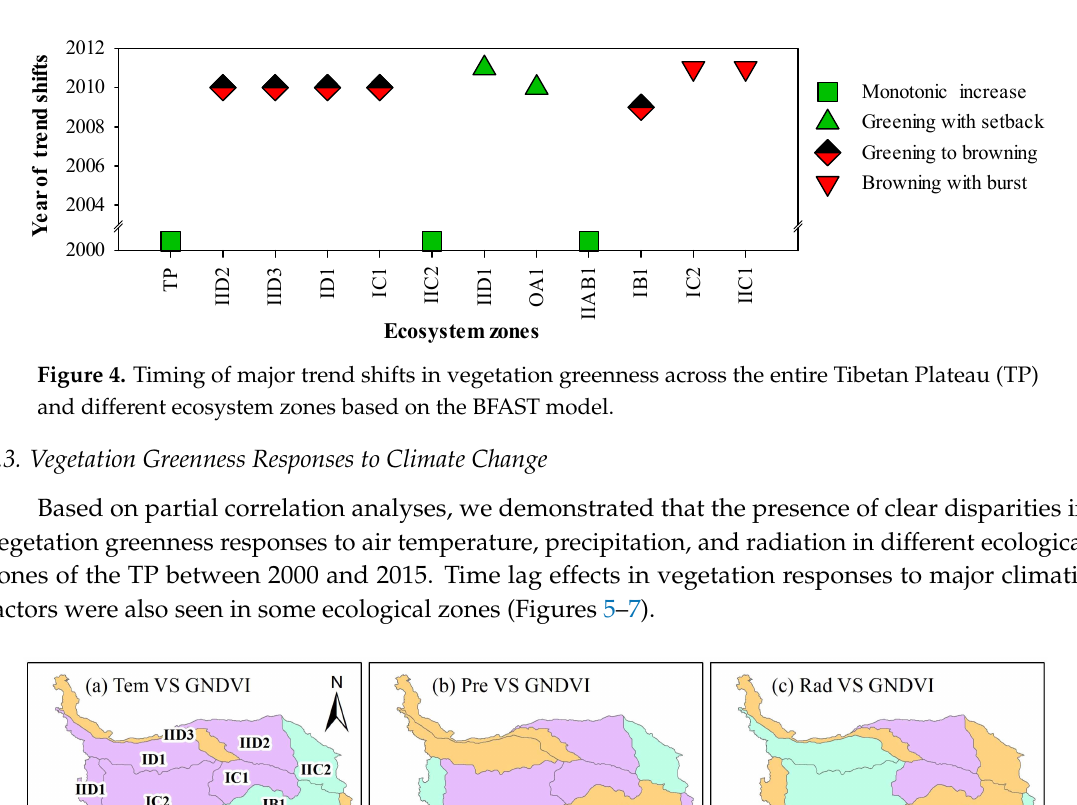
7 of 16 Figure 3. Change percentages of growing season NDVI (GNDVI) across different elevation bins ( a ) and ecosystem zones ( b ) on the Tibetan Plateau (TP). *** p < 0.001; ** p < 0.01; * p < 0.05. 3.2. Major Shifts in Vegetation Greenness Trends Based on the BFAST model, we examined the major trend shifts in vegetation greenness across the entire TP and different ecosystem zones (Figure 4 and Figure S1). Monotonic greening trends in vegetation greenness were detected across the vegetated areas of entire TP. The trend shifts in vegetation greening and browning regimes, however, varied depending on ecosystem zones. All